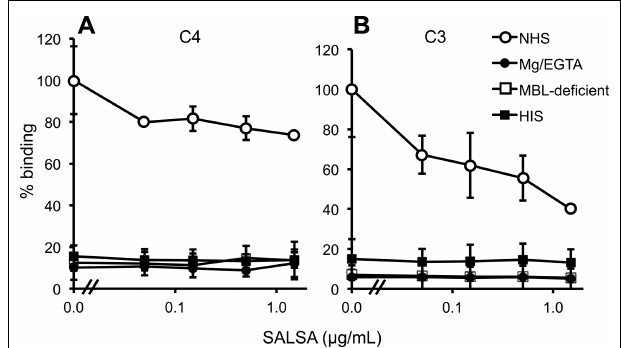
FIGURE 7 | Complement inhibition by fluid-phase SALSA. In a flow cytometry assay C. albicans was incubated in 10% NHS, MBL-deficient serum, MgEGTA-serum, or HIS with rSALSA (0–15 μ g/ml). Complement deposition was measured using anti-C4 (A) and anti-C3 (B) antibodies.